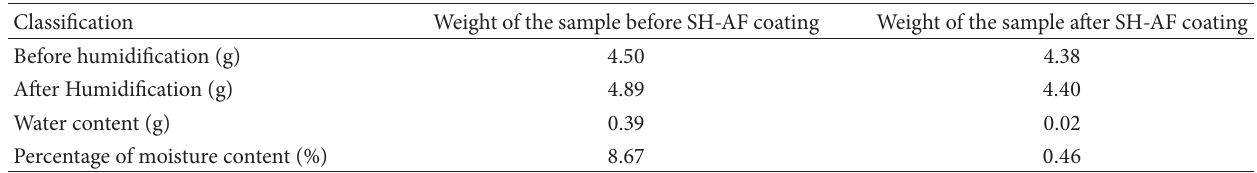
Table 2: Moisture absorption amount of glass wool before and after SH-AF